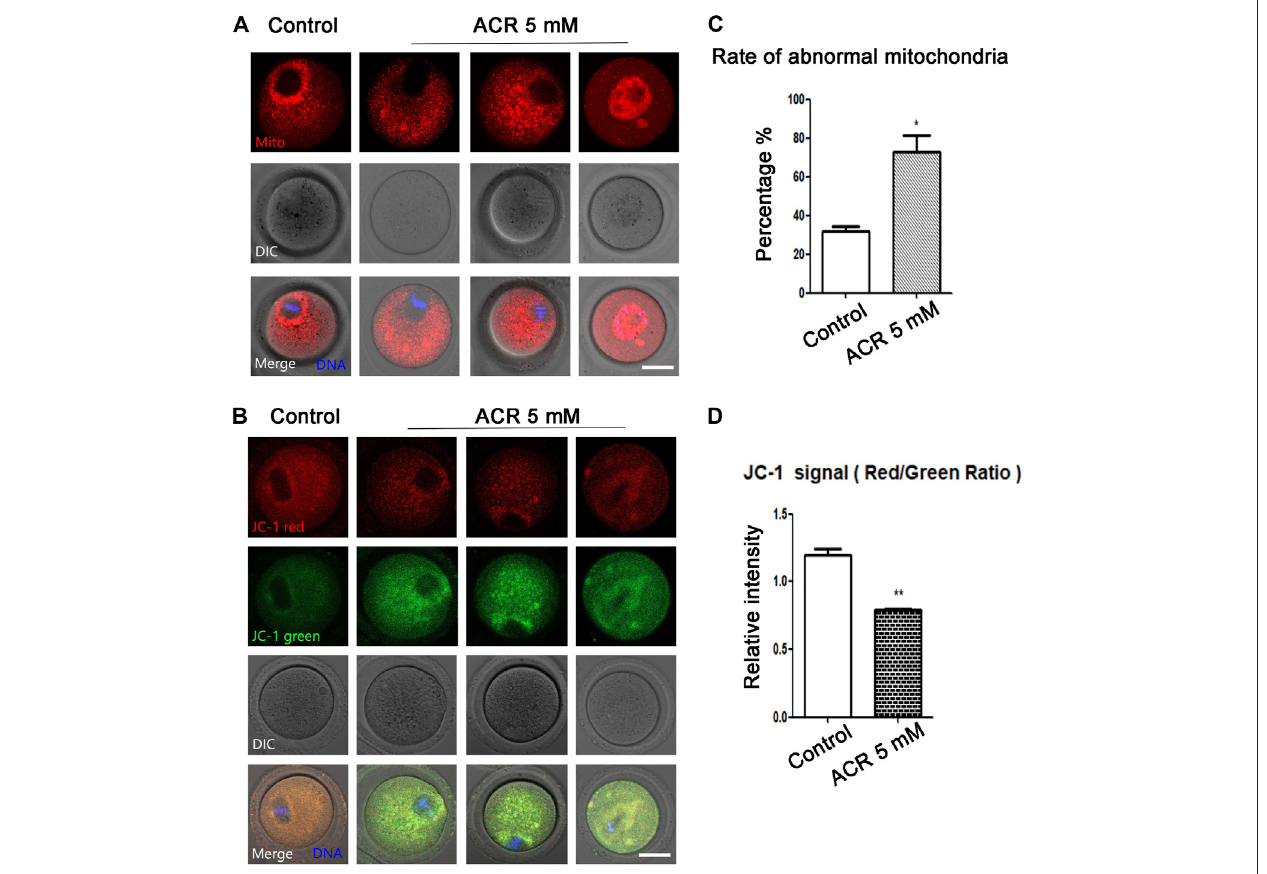
FIGURE 2 | Toxic effect of ACR on mitochondria in mouse oocytes. (A) The typical picture of the distribution of mitochondria in oocytes after ACR exposure. In control oocytes, mitochondria accumulated at the spindle periphery but diffused in the treatment groups. Red, Mito-Tracker; blue, DNA. Bar = 30 μ m. (B) The typical picture for Mitochondria-JC-1 red channel and green channel after ACR exposure in oocytes. Blue, DNA. Bar = 30 μ m. (C) The abnormal rate of mitochondrial distributioninoocytesafterACRtreatment.Histogramshowedthattheabnormalrateofmitochondriaincreasedsigni fi cantlyin5mMACRgroups.**, p < 0.01. (D) The mitochondrial JC-1 signal ratio (red/green) after ACR treatment. The histogram showed that the ratio of fl uorescence intensity of the JC-1 red/green channel was reduced in the 5 mM ACR group. ** p < 0.01.